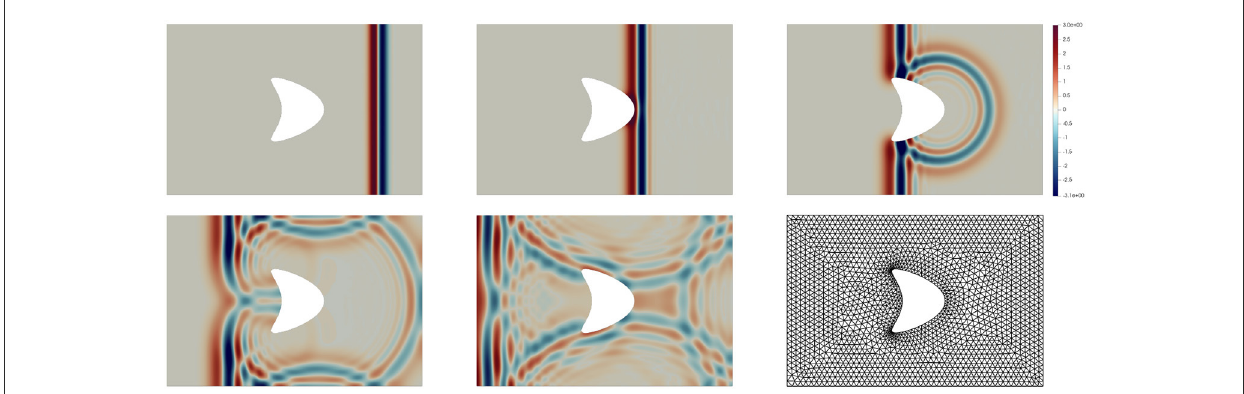
FIGURE3 Computational mesh of the rectangular domain (cid:127) with an obstacle (second row, right) used for all the computation. The first row and second (left and middle) show snapshots at t = 0,2,4,6,8 of the velocity variables v h approximated by the Hamiltonian HDG method (Equation 13) with polynomial approximation spaces of order 3 and the implicit